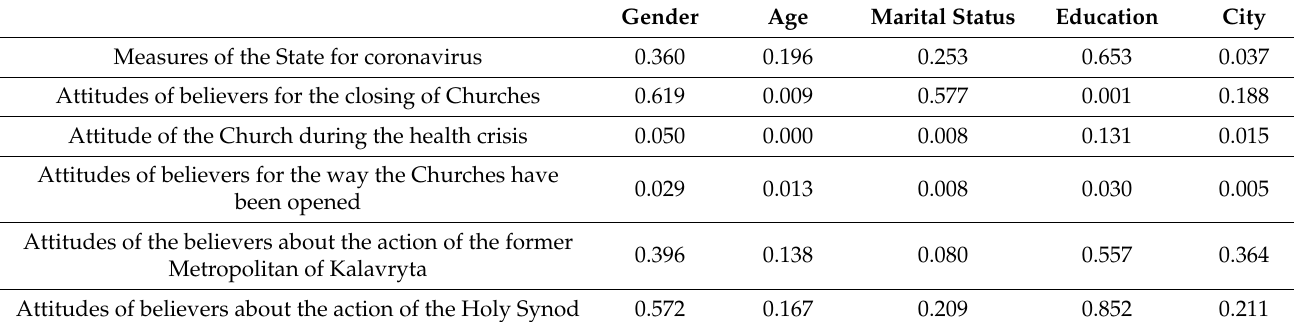
Table 9. p -values of chi-square tests between the dependent variables and demographic